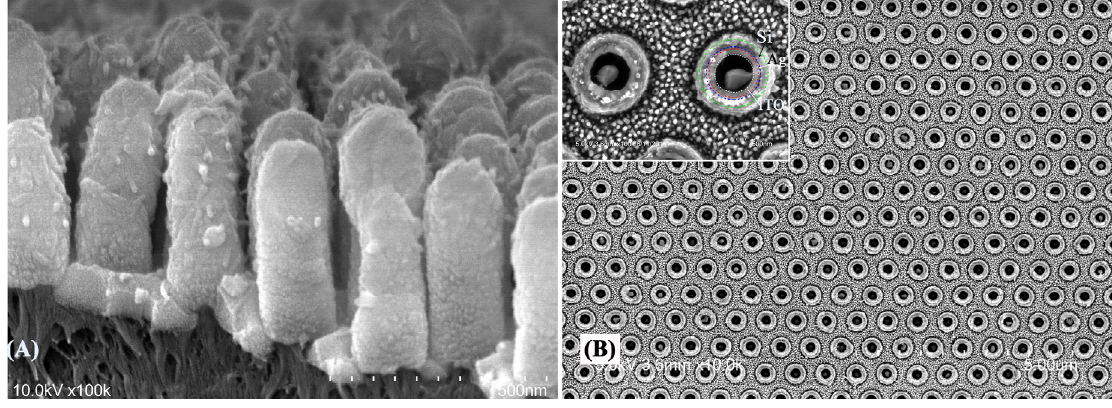
Figure 3. ( A ) SEM images of PAN/ITO/Ag nanopillars and ( B ) top view of etched PAN/Ag/ITO/Si multilayer